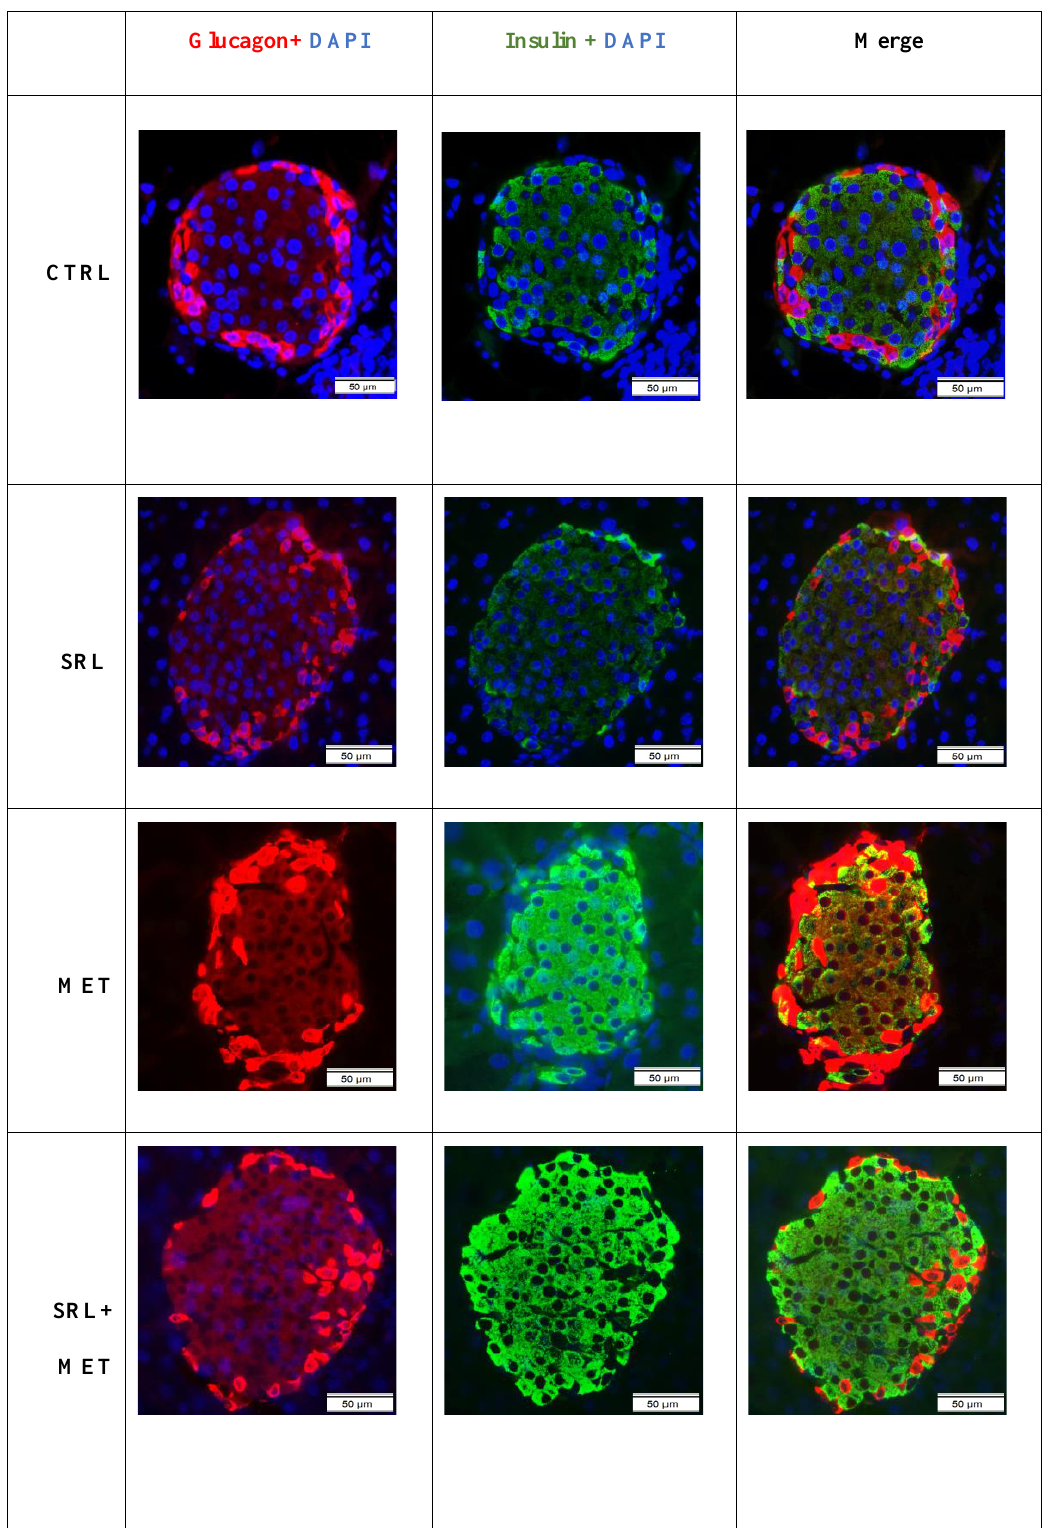
Figure 4. Immunofluorescence double labelling for insulin (red) and glucagon (green) in pancreatic islet cells from mice after one month of treatment with Water (CTRL), SRL alone, MET alone, and SRL+MET co-treatment groups. Pancreatic sections from Balb/C mice double immunostained for insulin (green) and glucagon (red), with nuclei visualized by DAPI staining. Magnification of 40X. n = 6